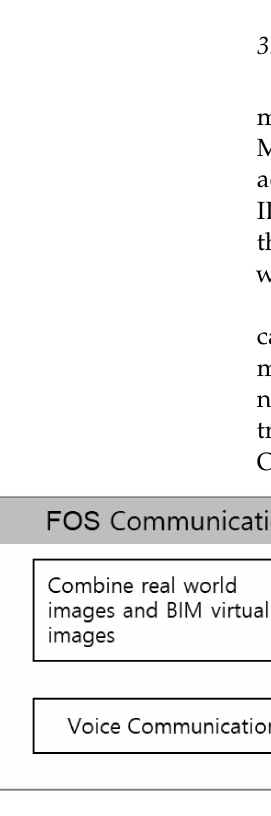
Figure 6. Data Flow between FOS and OMS Communication